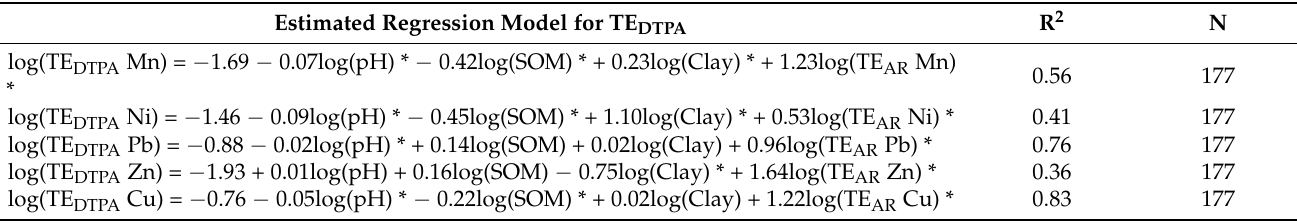
Table 4. Prediction model